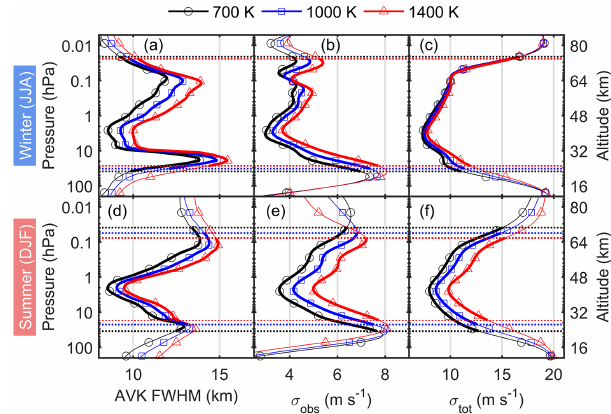
Figure 10. As Fig. 7, but for different radiometer system tempera- tures and a 60 ◦ zenith viewing